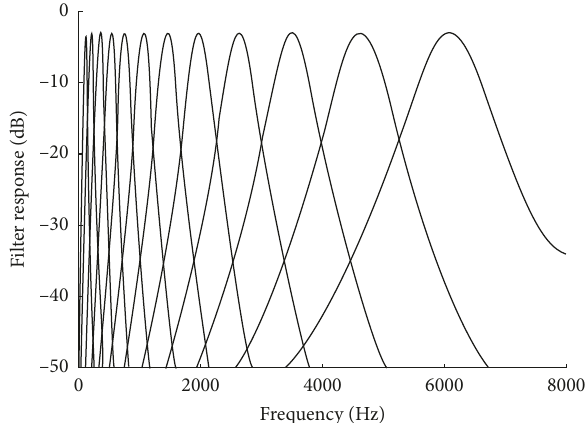
Figure 2: Shock response of gammatone filter